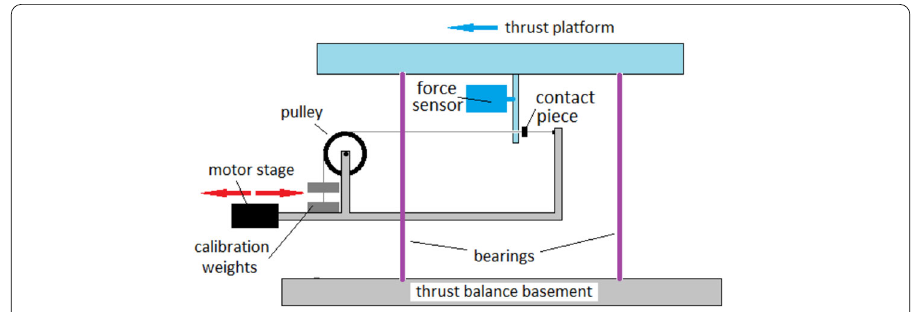
Figure 4 Schematic of the AST thrust stand calibration principle. A motorized motion stage moves to the left, the wire contact piece touches the thrust platform, which then lifts weights. This pulls the thrust platform via a wire and a pulley that transforms the vertical force into a horizontal